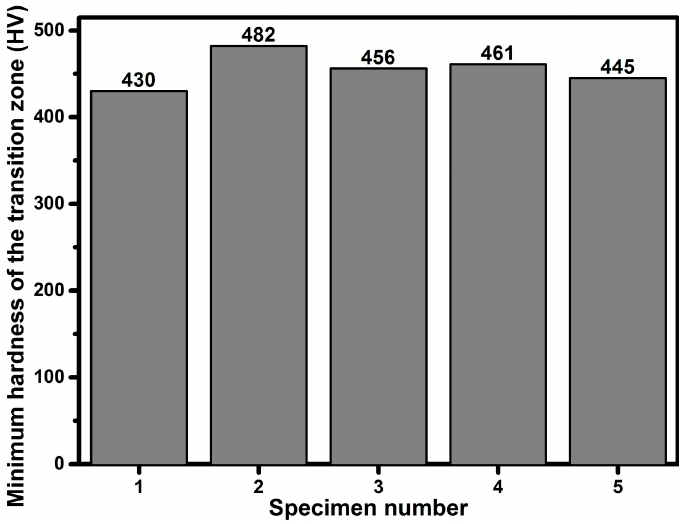
Figure 13. Microhardness fluctuation in the transition zone of the overall joint.